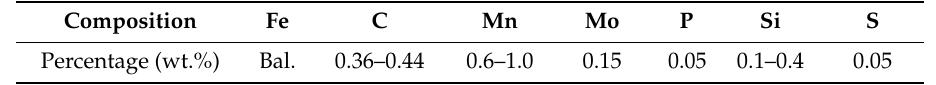
Table 1. Chemical composition of EN8 Steel.